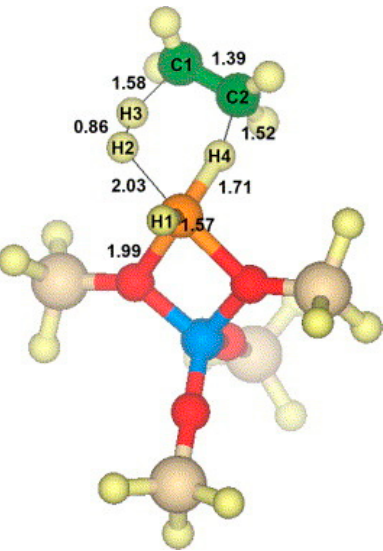
Figure 16. Ethane dehydrogenation reaction through the 3-step mechanism. Reprinted with permission from ref [132]. Copyright 2005 Elsevier.